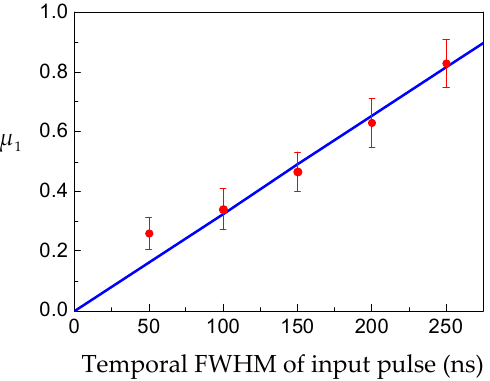
Figure 6. The mean number of photons in the input pulse to achieve SNR = 1 ( µ 1 ) as a function of the FWHM of input pulse. The pumping power is 315 mW. The solid line is a linear fiting with no offset.